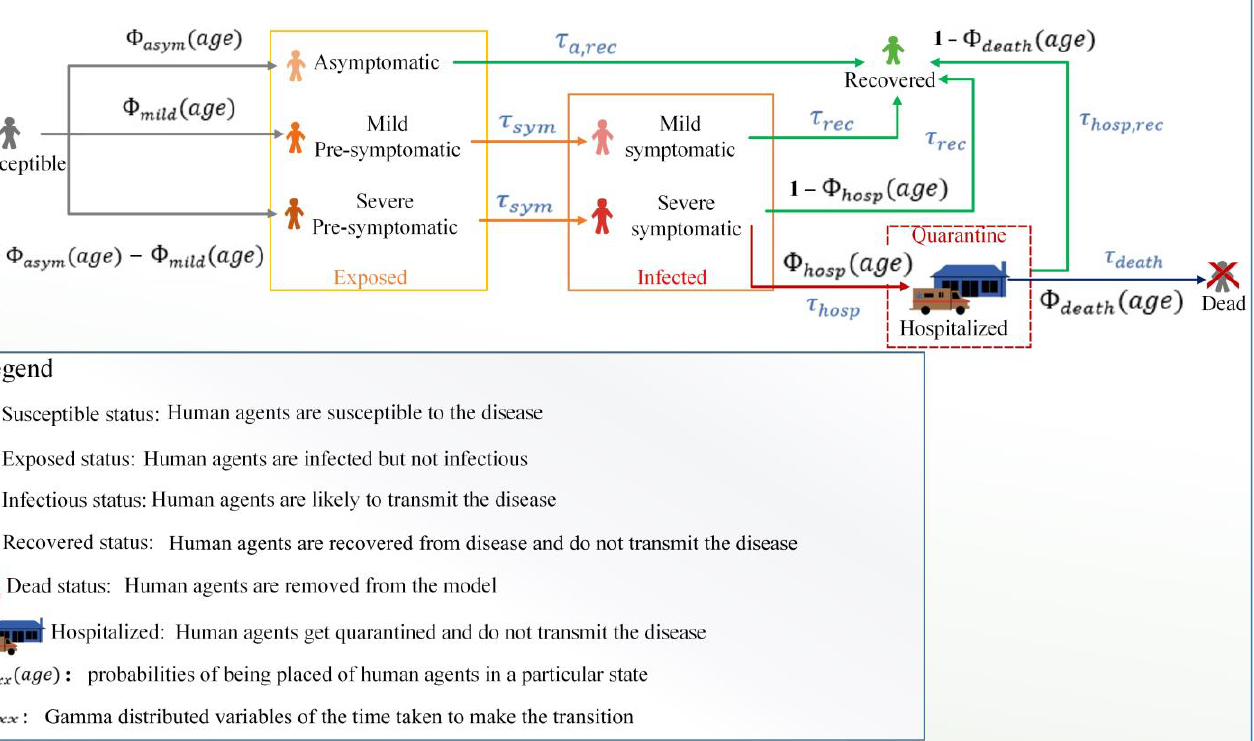
Figure 4. The probability and time distribution of transitions, and the health status of human agents.